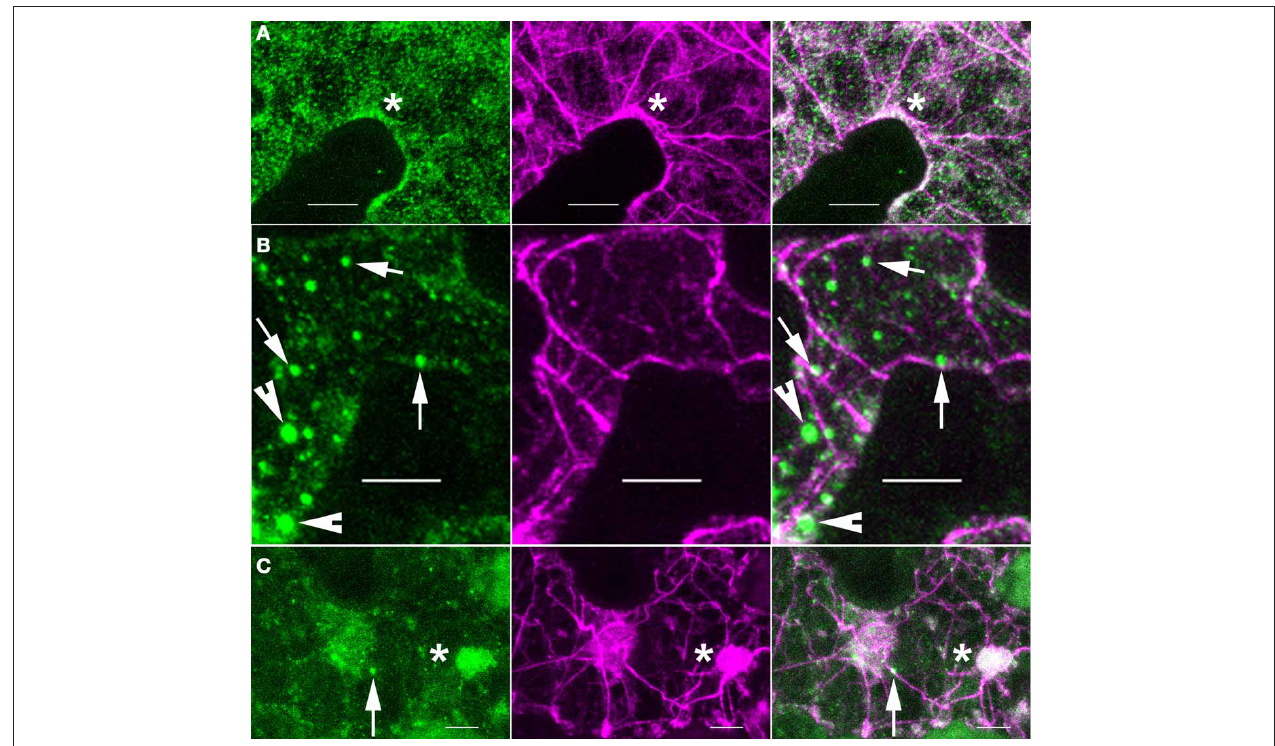
FIGURE 3 | ARP2/3 is concentrated on a heterogenous population of organelles, most of which are adjacent to actin bundles. Left panels, anti-HA. Middle panels, anti-ACTIN. Right panels, merge of left and right panels. (A) ARP2/3 has a patchy granular appearance in some pavement cells. (B) ARP2/3 is localized to small punctate structures of